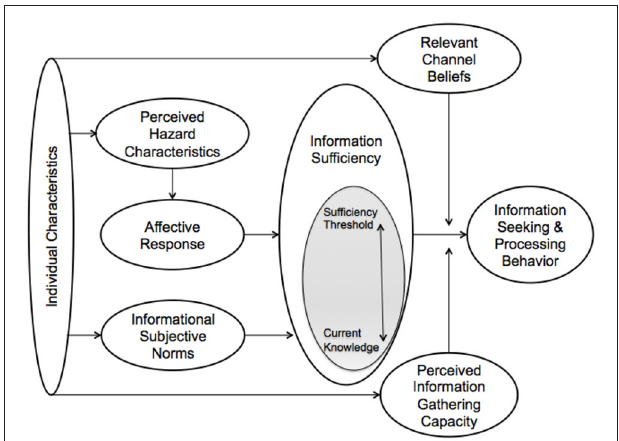
FIGURE 1 | Risk Information Seeking and Processing Model [adapted from (6)].